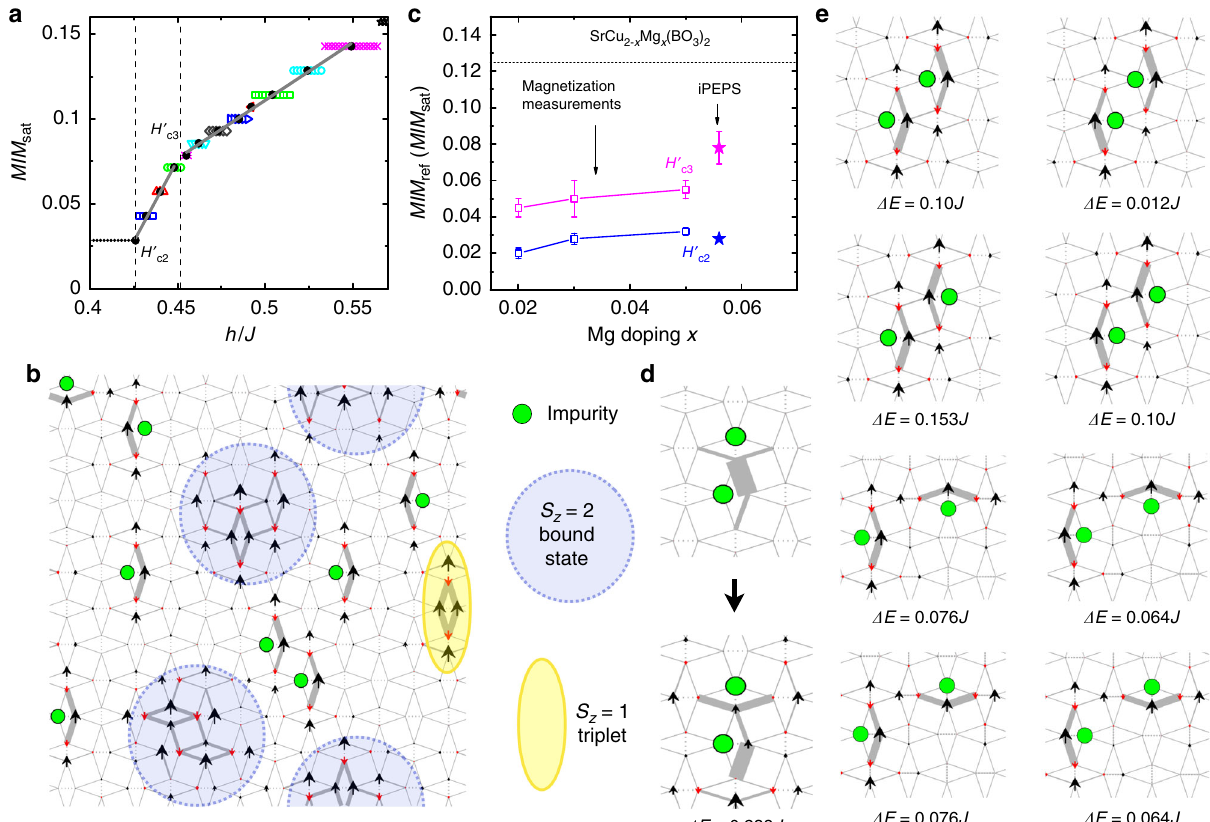
Fig. 5 iPEPS simulation and magnetization measurements for the Mg doped SS model. a iPEPS magnetization curve obtained using a 12 × 12 unit cell with eight impurity sites. Black solid dots represent the centers of the plateaus. The full lines are linear fi ts to the black solid dots at high and low- fi eld regions, respectively. Dashed lines indicate H ’ C2 , and H ’ C3 . A clear slope change is identi fi ed at H ’ C3 . b Example spin con fi guration obtained in the total S z = 11 sector. The size of the spins scale with the magnitude of the local magnetic moment, where black (red) arrows point along (opposite to) the external magnetic fi eld. The thickness of the gray bonds scales with the local bond energy (the thicker the lower the energy). c Mg-doping dependence of the normalized magnetization, M / M ref , at H ’ C2 (magenta) and H ’ C3 (blue), obtained from experimental results on the x = 0.02, 0.03, and 0.05 samples, along with iPEPS simulation results for M / M sat with an effective doping x = 0.056. Dashed line indicates the magnetization at the 1/8 plateau. The error bars of the magnetization measurements result from the uncertainty in determining magnetization values using the method shown in Supplementary Fig. 3. The iPEPS error bar takes into account the uncertainty of the location of H ’ C3 due to the fi nite unit cell size. d Special 2-impurity con fi guration in the S z = 0 (top) and S z = 1 (bottom) sectors, respectively, with an excitation energy Δ E = 0.238 J . e Special 2-impurity con fi gurations obtained with iPEPS which lead to additional excitation levels below H ’ C1 - at an onset fi eld H ’ C0 , as observed in the x = 0.05